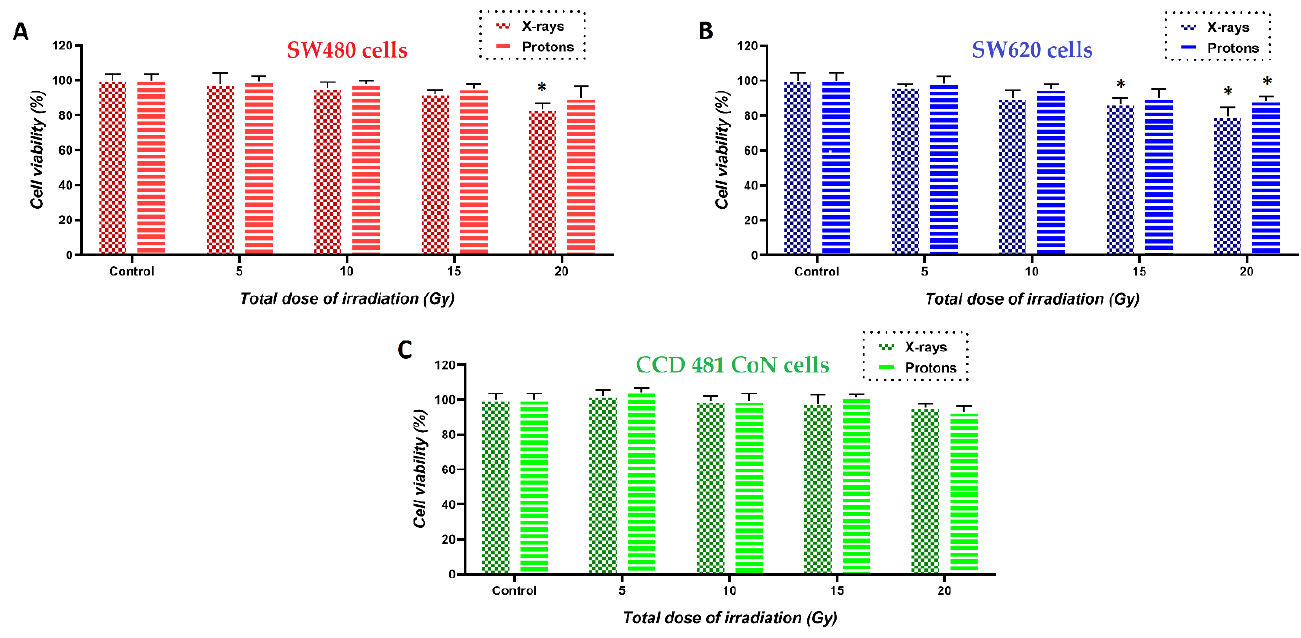
Figure 6. Viability of ( A ) SW480 (red bars), ( B ) SW620 (blue bars) and ( C ) CCD 841 CoN (green bars) cells treated with a different dose of X-rays and protons determined by the MTS test. Differences were considered significant when * p -value < 0.05 vs. control.